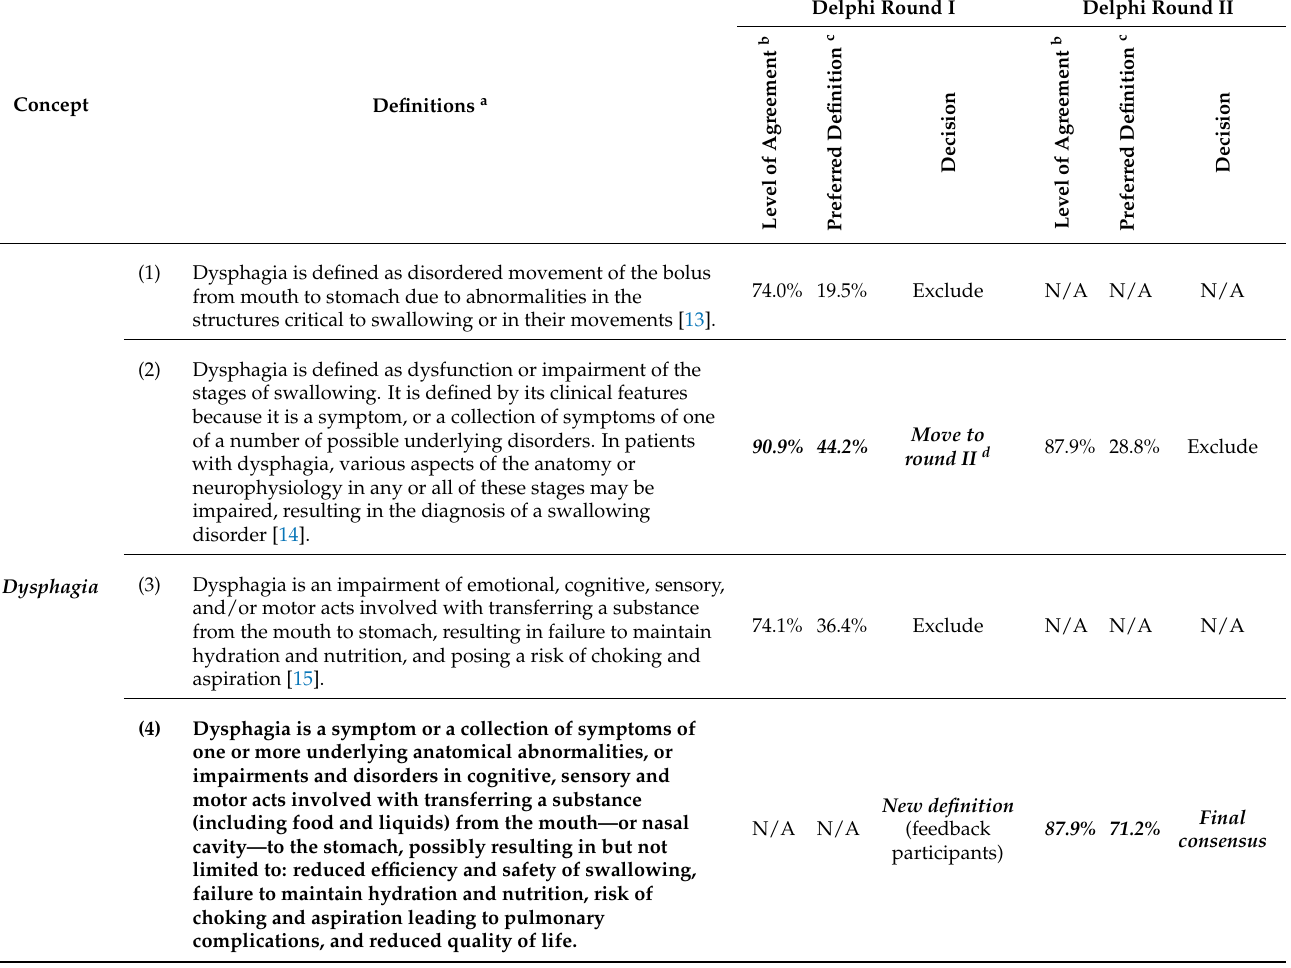
Table 1. Decision flow chart for definitions on dysphagia, FHS and HR-QoL: Delphi Round I and